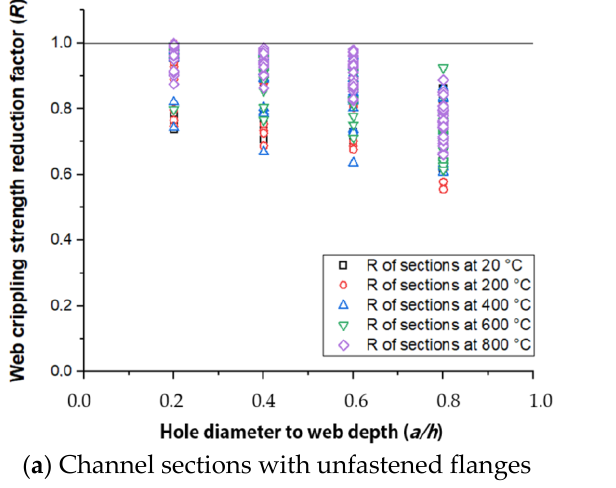
Figure 15. Strength reduction factor against a/h. Table 7. Average strength reduction factor ( R ) of investigated sections. Table 7. Average strength reduction factor ( R ) of investigated